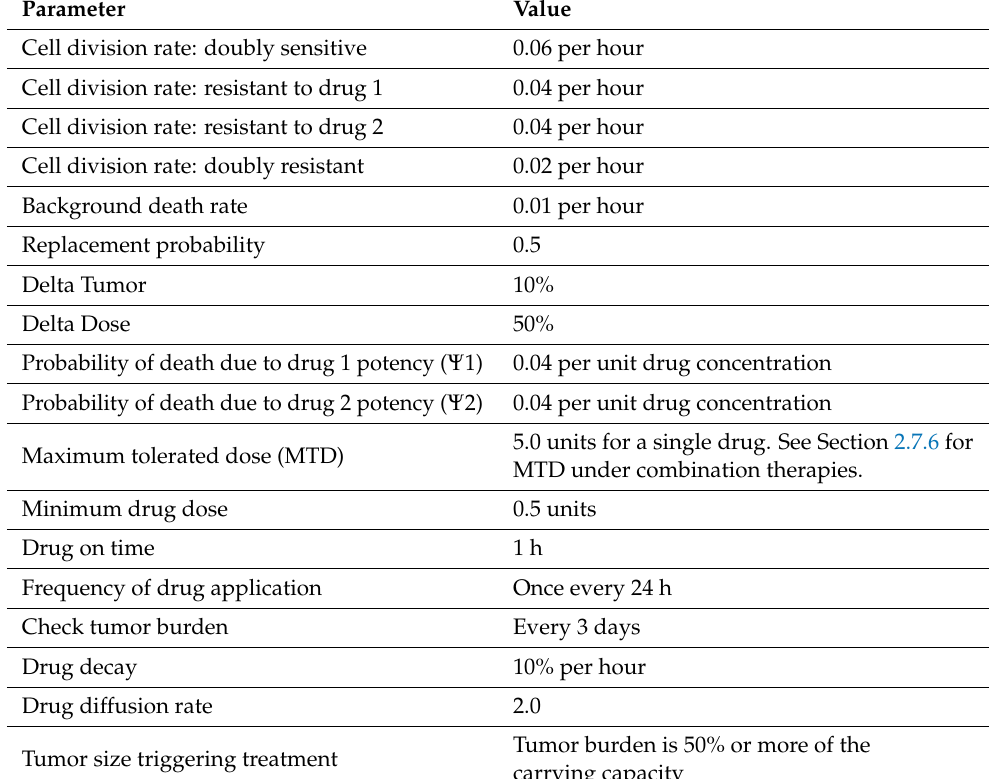
Table 1. Parameter table with default